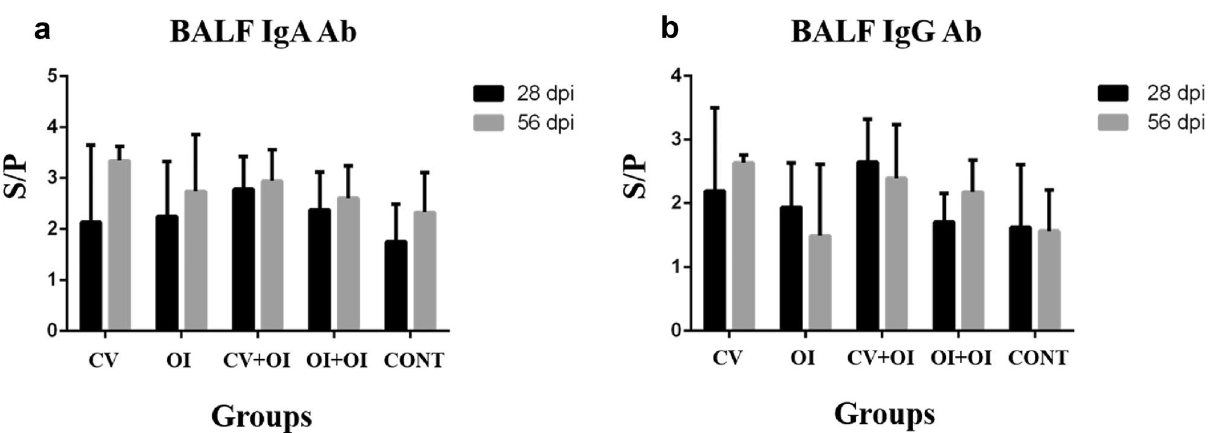
Figure 4. ELISA S/P (mean ± sd) results for BALF on 28- and 56 dpi regarding ( a ) IgA antibody response against M. hyopneumoniae ; ( b ) IgG antibody response against M. hyopneumoniae . Positive S/P values > 0.4.